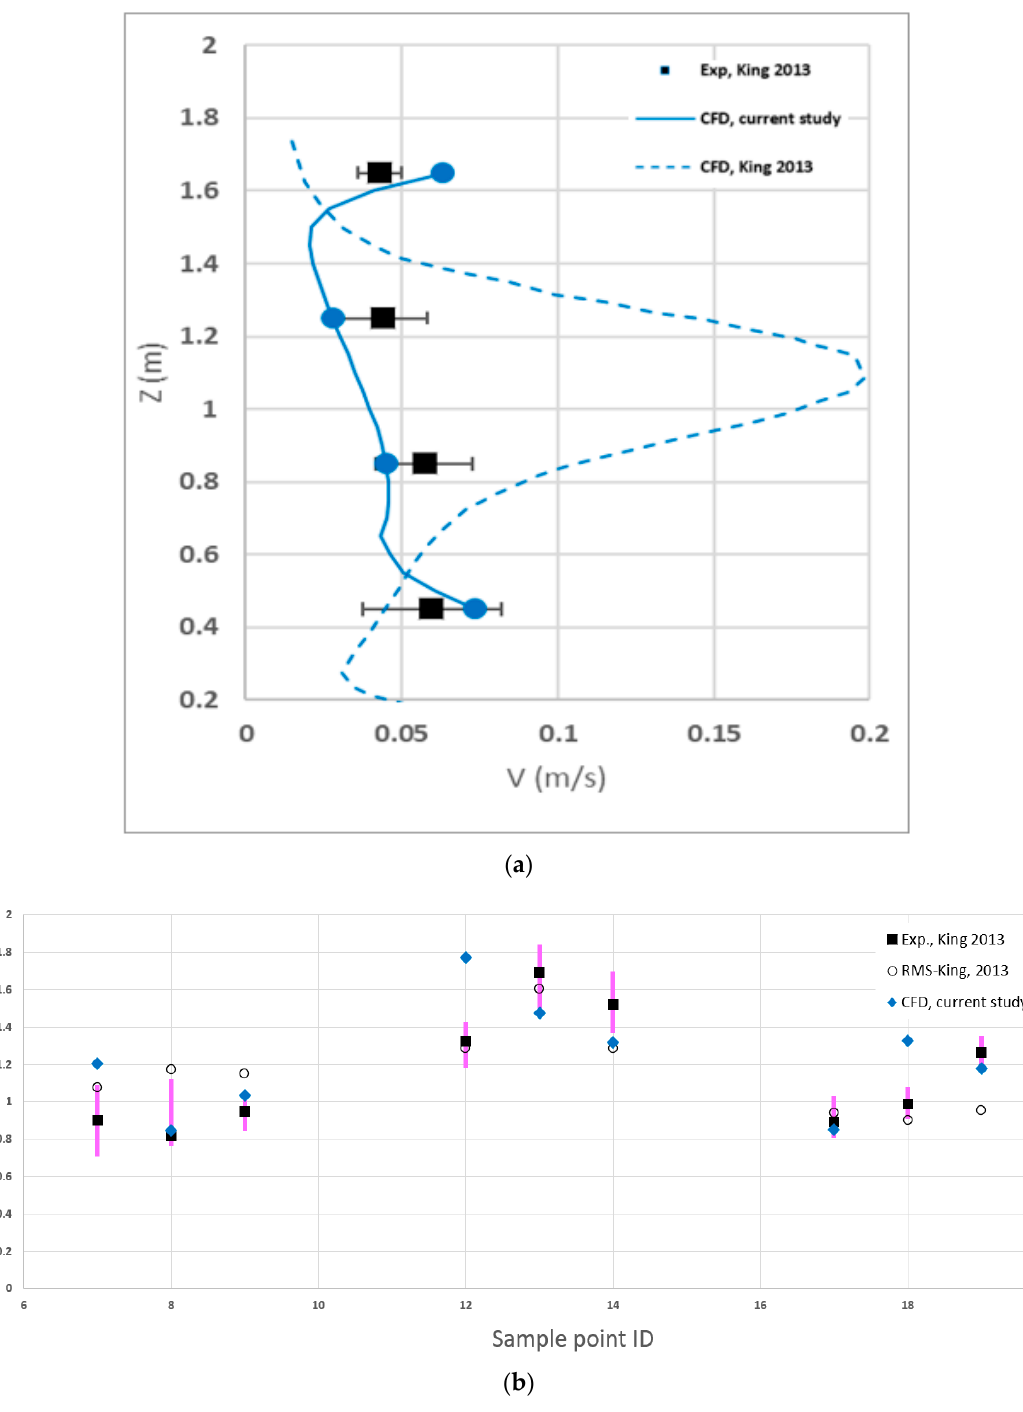
Figure 4. Comparison of the experimental and calculated values for the second validation experiment. ( a ) Velocity profile at pole 2. ( b ) Normalized deposition ratio at the room central locations shown in Figure 2b.